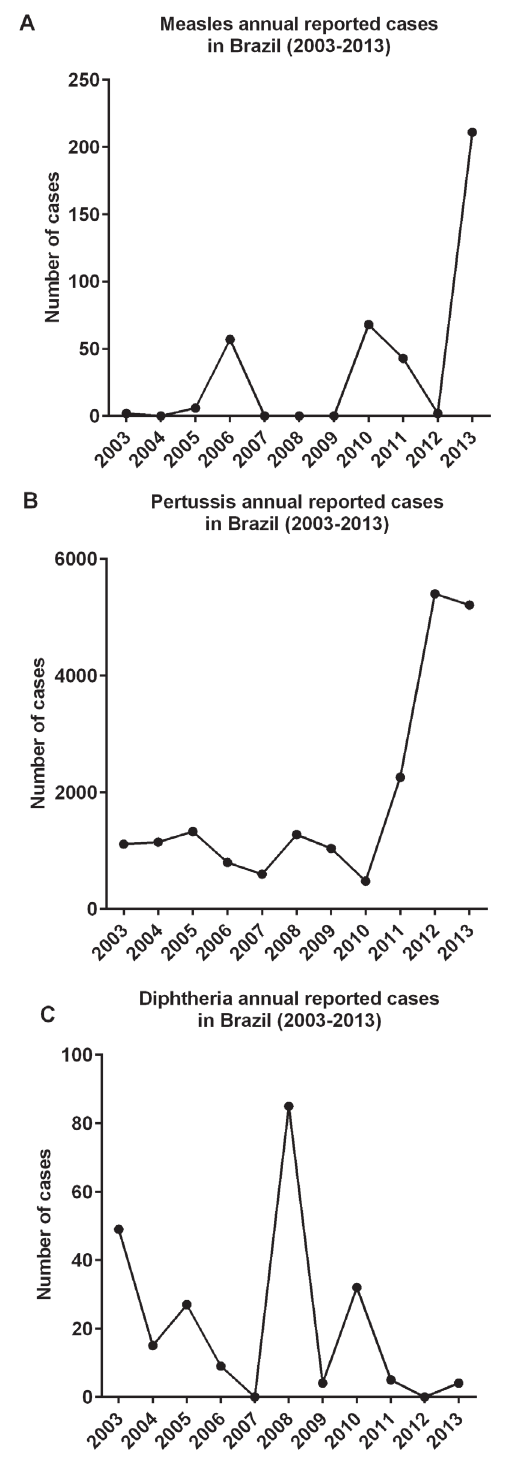
Figure 2 - Measles, pertussis and diphtheria annual reported cases in Brazil (2003-2013). a , measles; B , pertussis; C , diphtheria; data summarized from WHO (2014); http://apps.